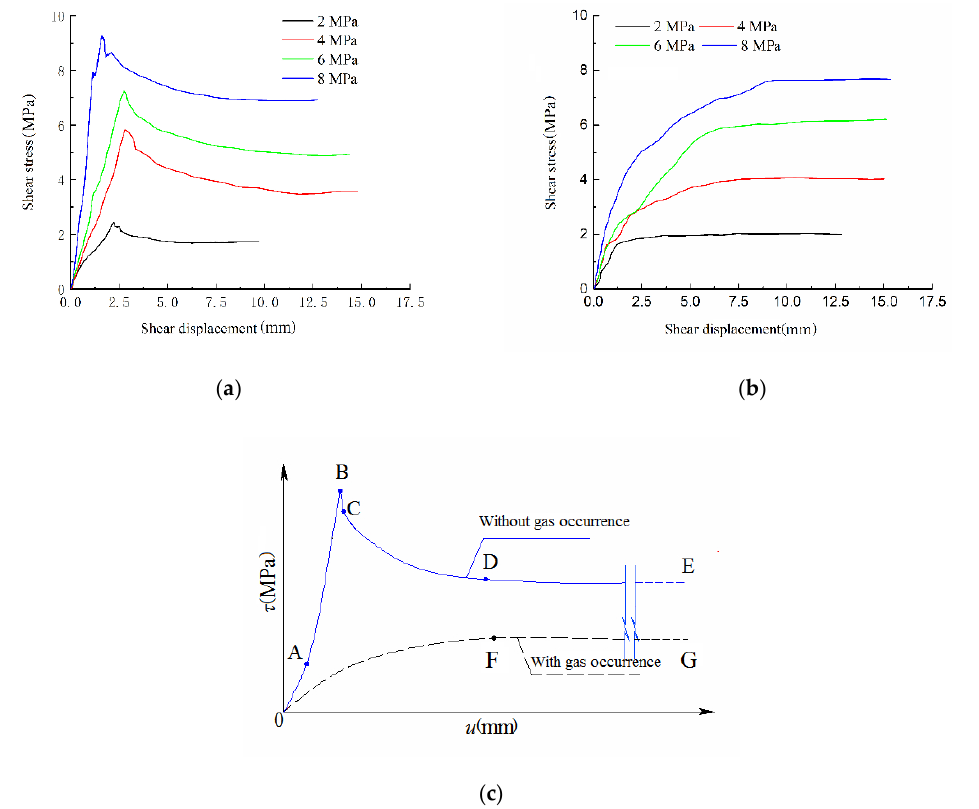
Figure 8. Shear stress–displacement curves of the grouted rock fracture ( a ) without gas occurrence and ( b ) with gas occurrence; ( c ) stress–displacement characteristics.